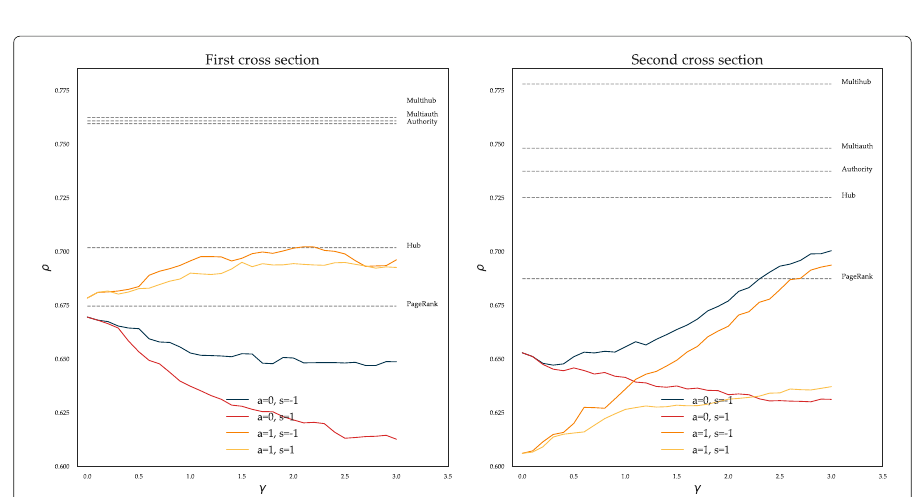
Fig. 19 Spearman correlation of rankings of different measures of node centrality with respect to ranking by